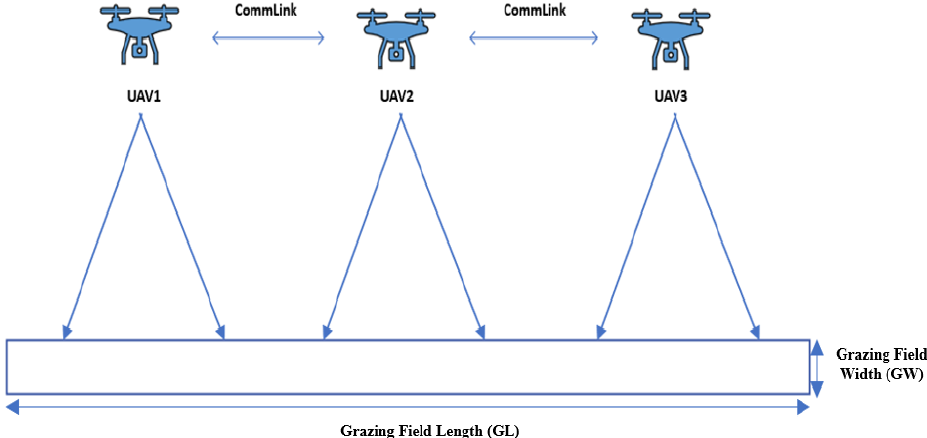
Figure 4. Grazing Field Movement Scenario.